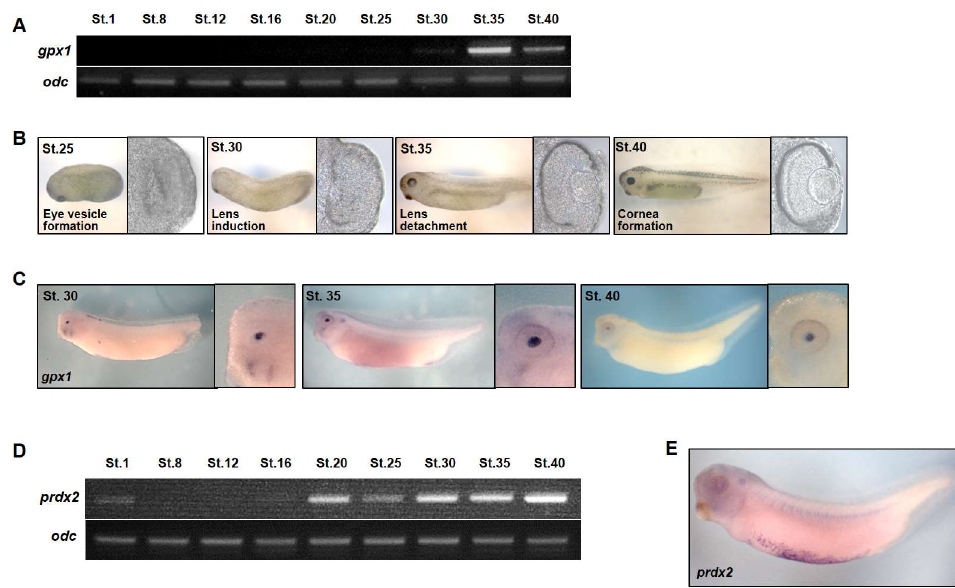
Figure 1. Spatiotemporal expression pattern of gpx1 and prdx2 during Xenopus embryogenesis. ( A ) The transcriptase-polymerase chain reaction (RT-PCR) analysis indicated the zygotic nature of gpx1 during Xenopus embryonic development. The temporal expression of gpx1 started at NF. St. 30 of embryogenesis and proceeded until NF. St. 40. The highest expression level was observed at NF. St. 35 of Xenopus embryogenesis. Ornithine decarboxylase ( odc ) was used as an internal loading control. ( B ) The general scheme for Xenopus eye development in the tadpole stage indicates eye vesicle formation at NF. St. 25, followed by lens induction at NF. St. 30., while lens detachment begins at NF. St. 35, leading to cornea formation at NF. St 40 of Xenopus embryonic development. ( C ) The spatial expression of gpx1 as analyzed by whole-mount in situ hybridization (WISH) indicated its specific expression in the lens after eye vesicle formation at NF. St 30 embryonic development with an increased expression level in the lens region at NF. St. 35 and it proceeded until NF. St. 40 of Xenopus embryogenesis. ( D ) RT-PCR analysis revealed the maternal nature of prdx2 during Xenopus embryogenesis. The highest level of prdx2 expression was observed at the late neurula and tailbud stages of embryogenesis. Ornithine decarboxylase ( odc ) was used as the internal loading control. ( E ) WISH analysis indicated the localization of prdx2 in embryonic VBIs during Xenopus embryonic development.